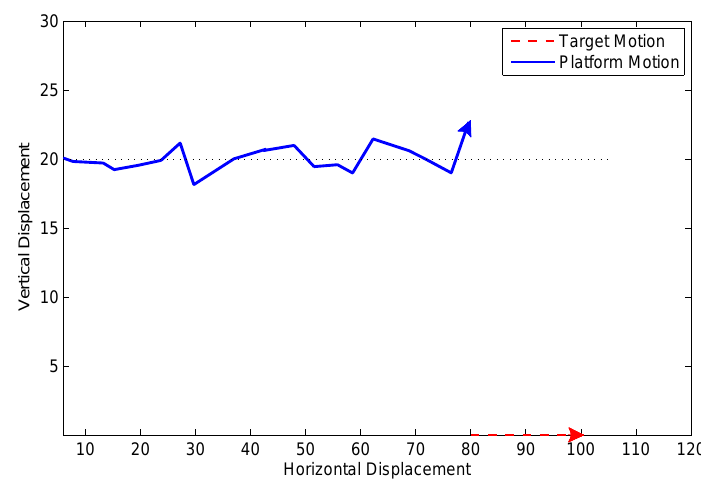
Figure 1. Target-observer geometry in Scenario